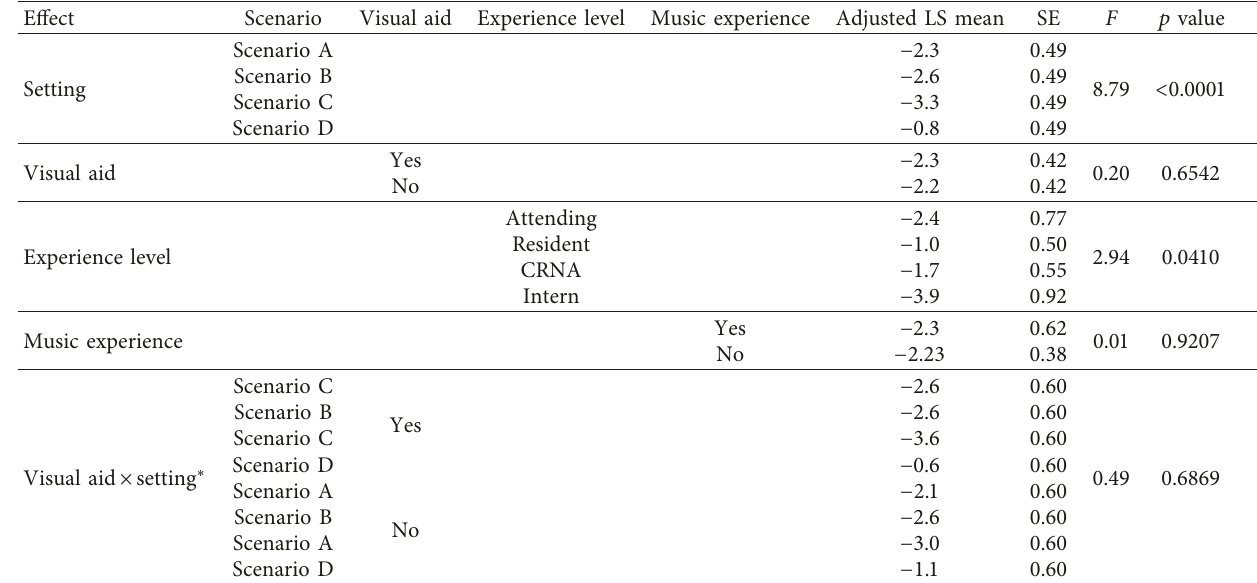
2 estimation accuracy under different recording settings (